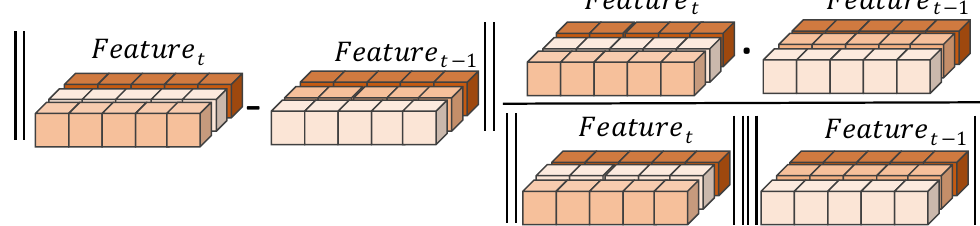
Figure 3. Schematic diagram of boost correlation feature